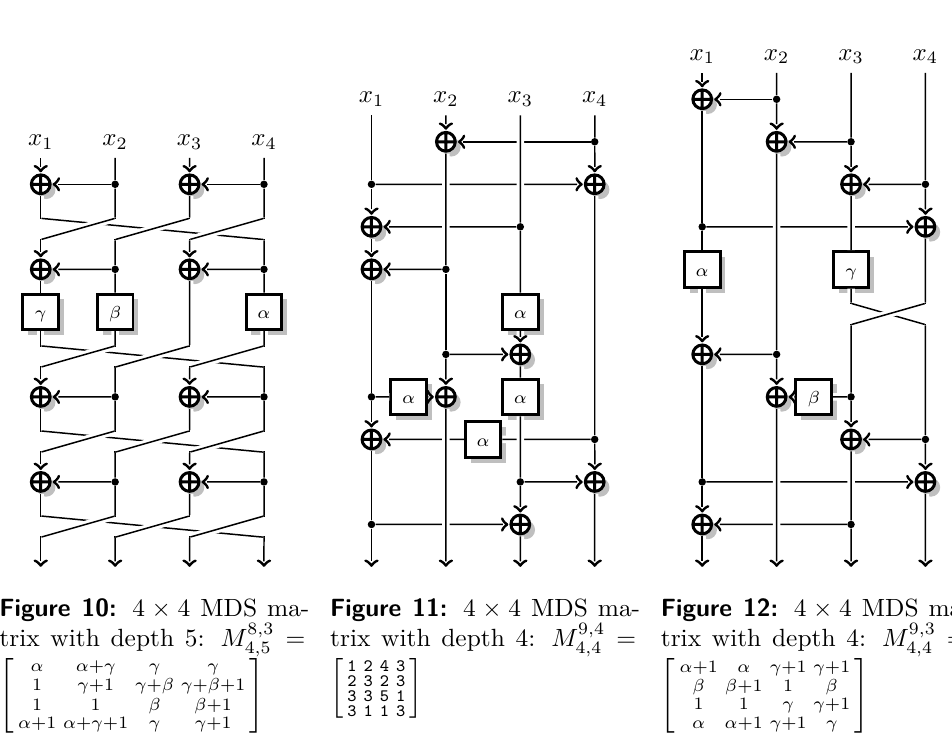
Figure 8: 4 × 4 MDS matrix with depth 6: (cid:20) 3 1 4 4 1 3 6 4 M 8 , 3 = 4 , 6 2 2 3 1